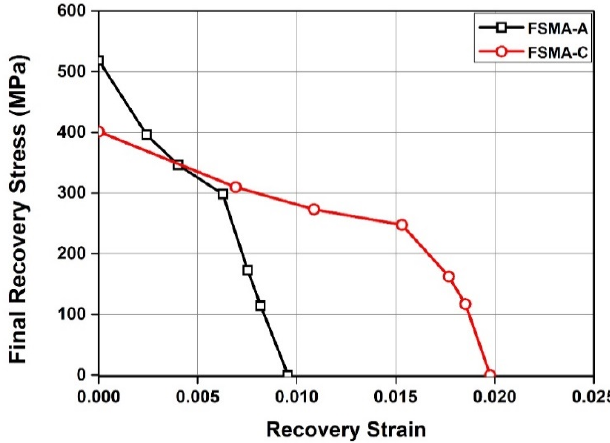
Figure 12. Recovery strain ‐ stress relationship of FSMA ‐ A and FSMA ‐ C.